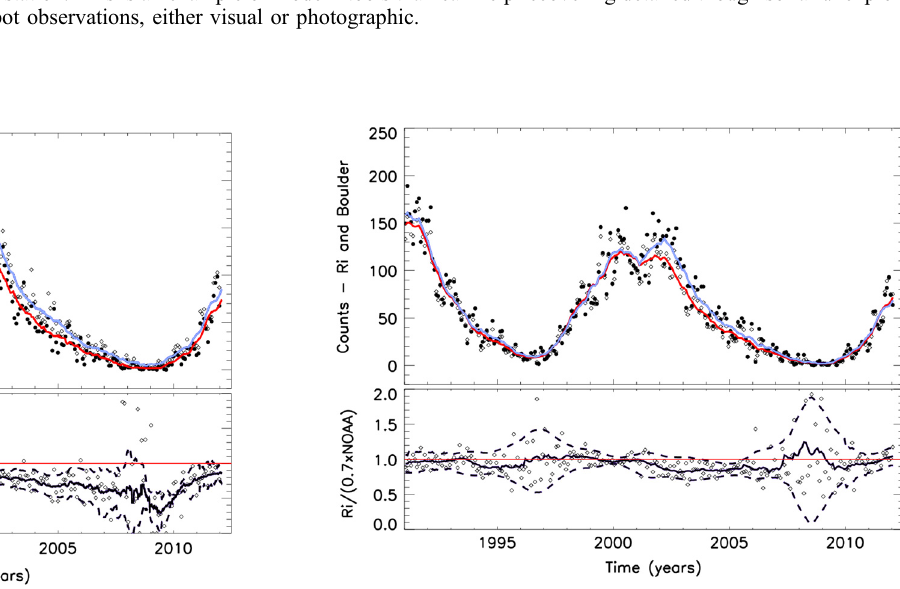
Fig. 9. Close-up view of the compared evolution of R i and F 10.7 over the last decade (same layout as Figs. 1 and 2). It shows the apparent recovery of the ratio between those indices after the onset of cycle 24, although the ratio has not returned yet exactly to the pre-2000 value.